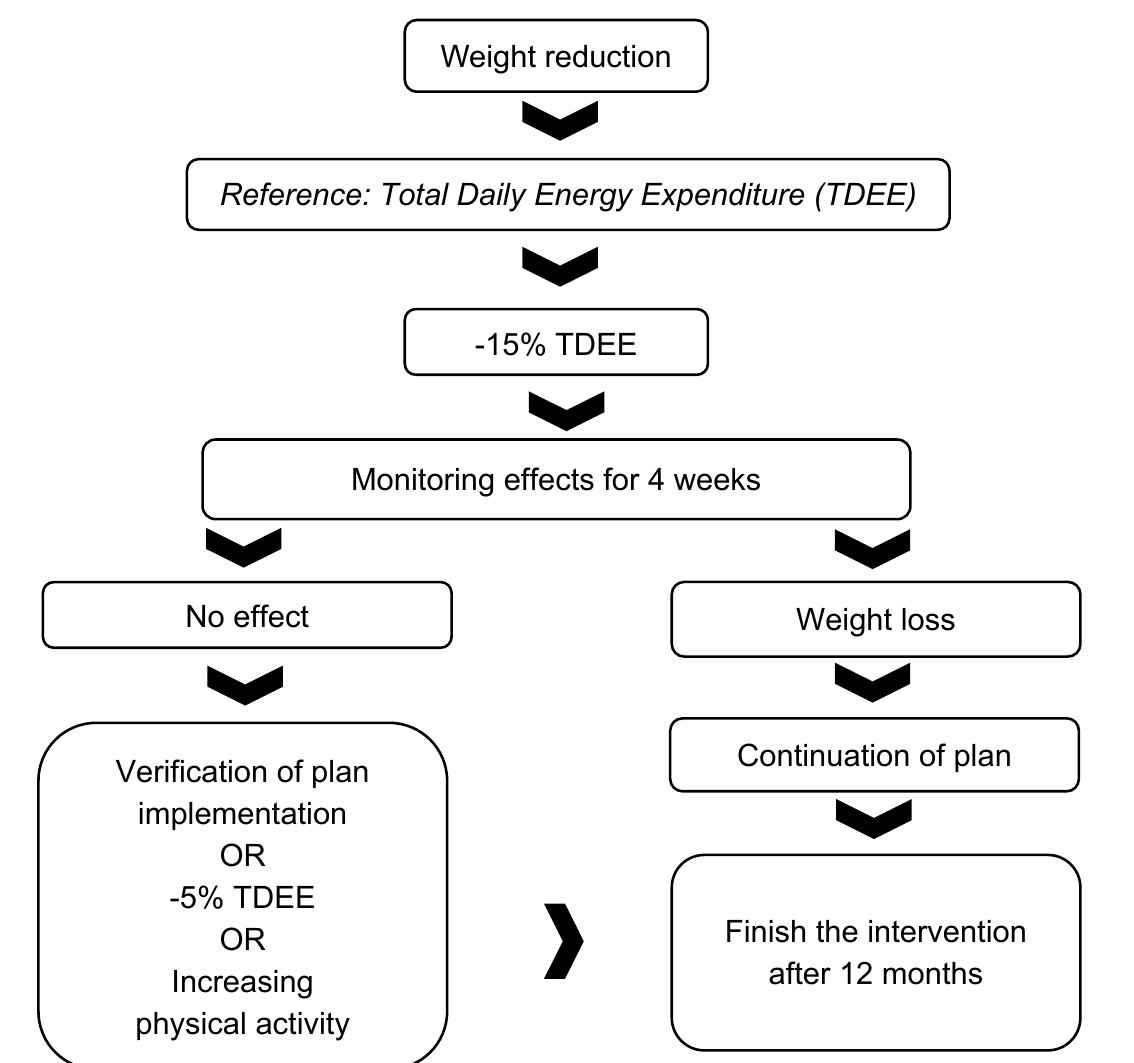
Figure 1. Protocol for adjusting the energy value of the diet throughout the nutrition intervention.